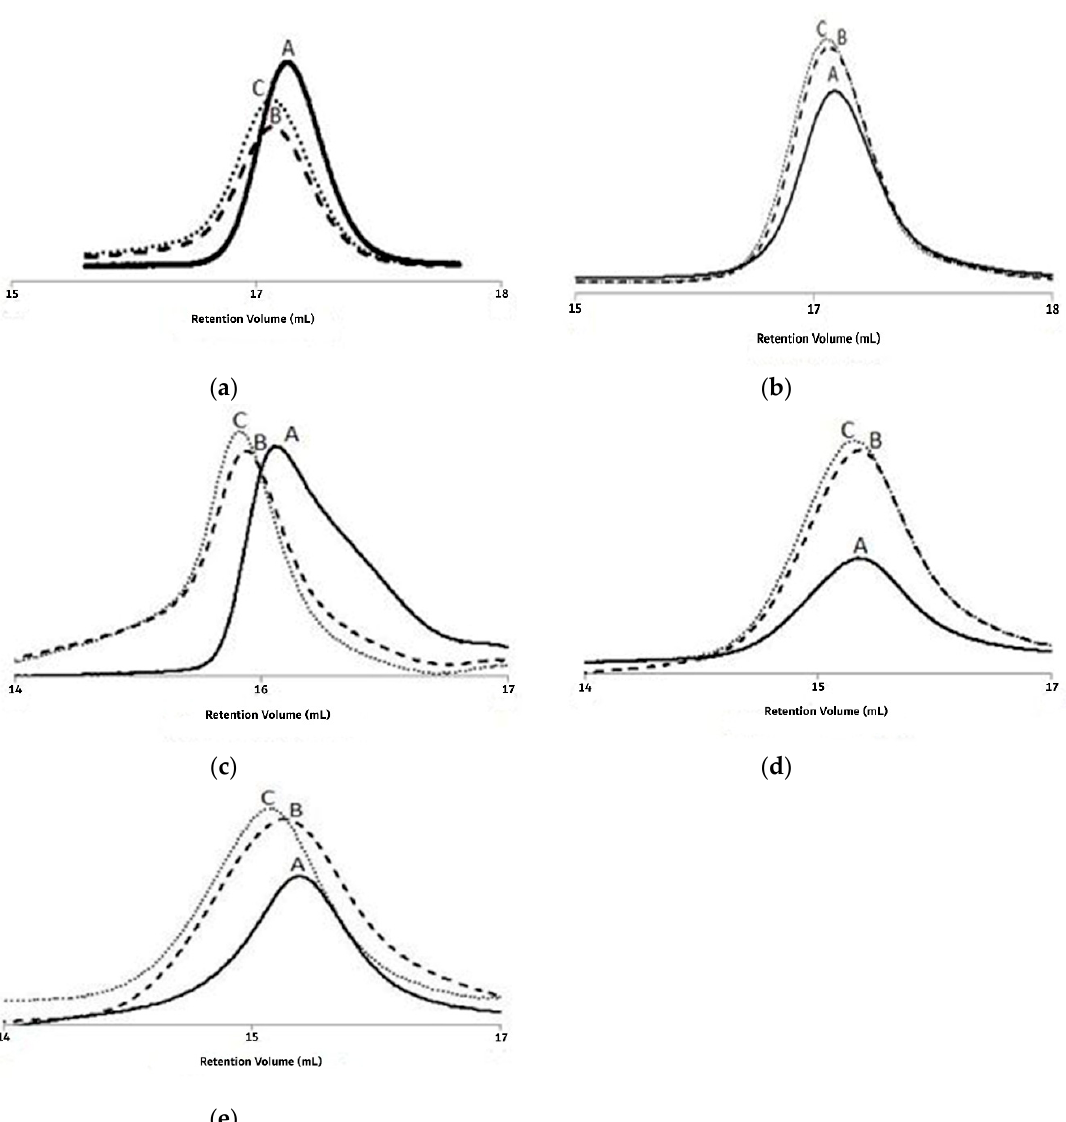
Figure 4. For experiments E12 and E13: ( A ) methyl methacrylate (MMA) conversion rate versus reaction time; ( B ) variations in the experimental number-average molar mass (M n ) versus the methyl methacrylate (MMA) conversion rates; and ( C ) variations in the polydispersity index (Ð) versus the methyl methacrylate (MMA) conversion rates.